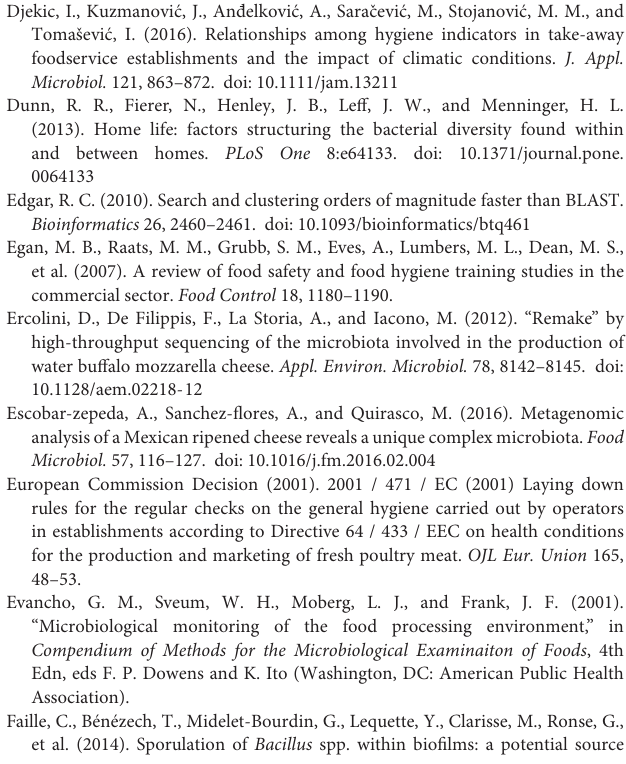
Supplementary Table 1 | Summarized analyzed sequence data information. Supplementary Table 2 | List of source contribution of bacterial